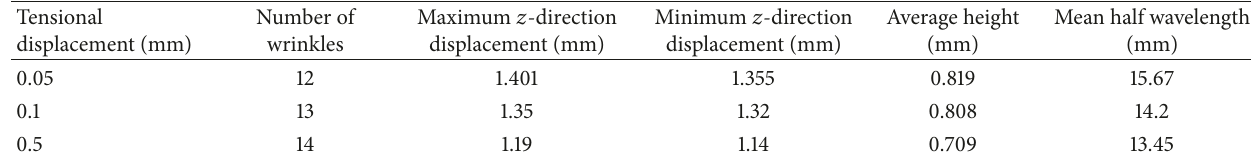
Table 7: Influence of initial prestress.